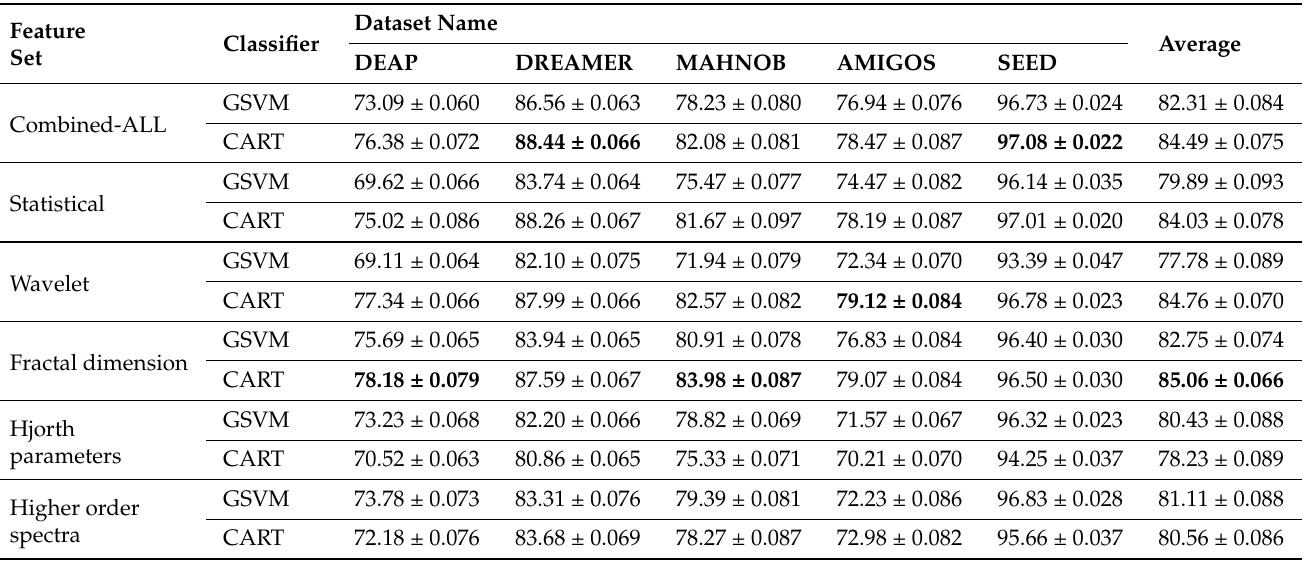
Table 3. Emotional Valence: Mean (±SD) EEG Feature-classification accuracy (%). Bold represents the highest average accuracy scores within and across each dataset.